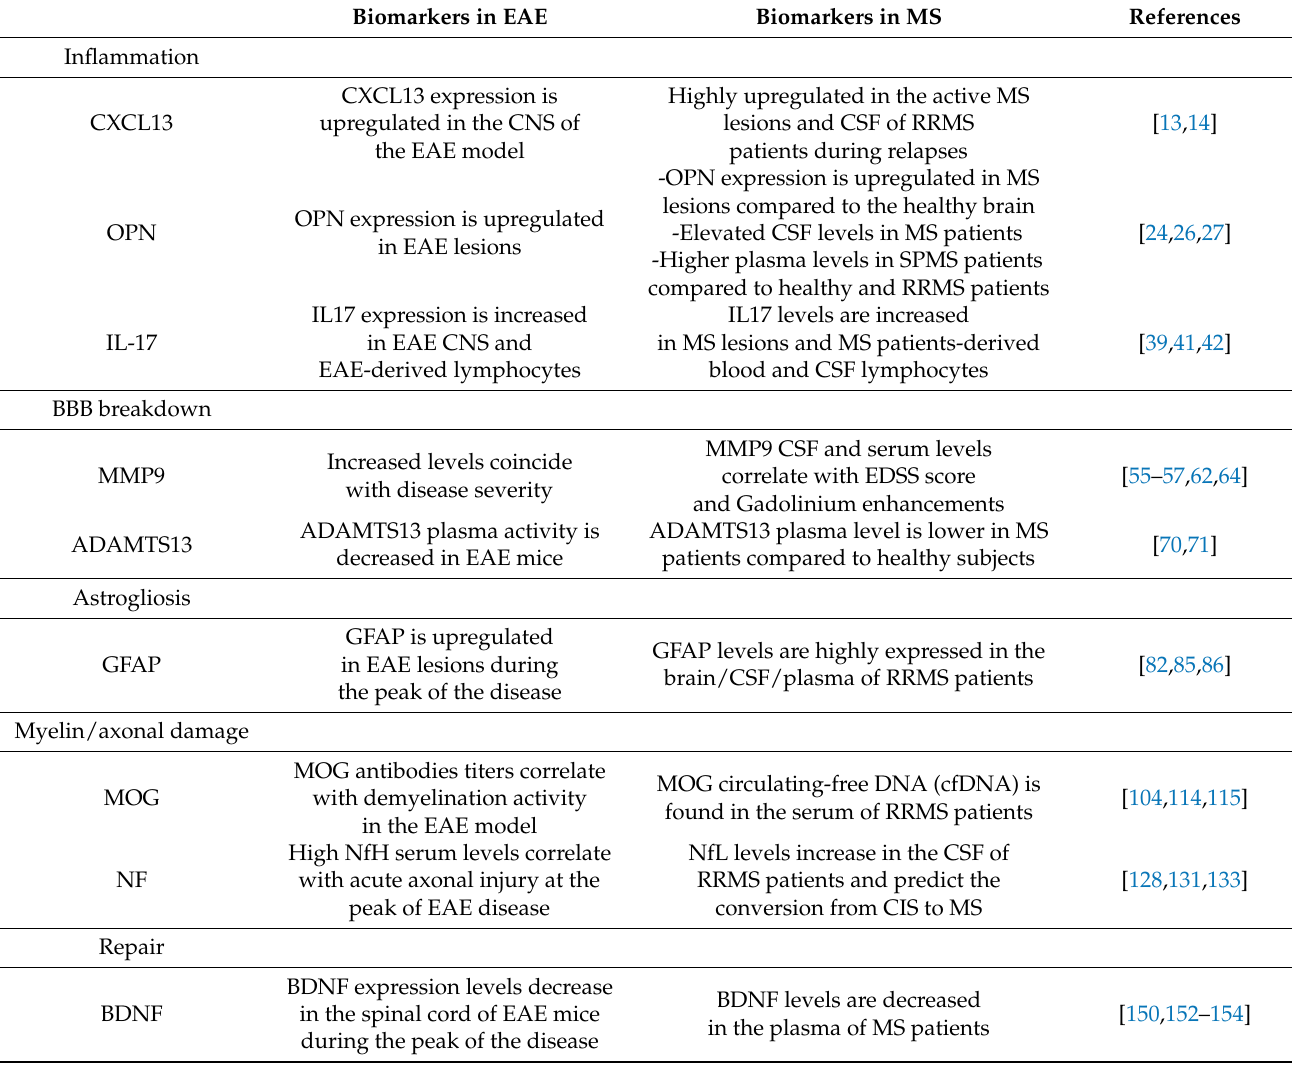
Table 1. Biomarkers expression in EAE models and MS